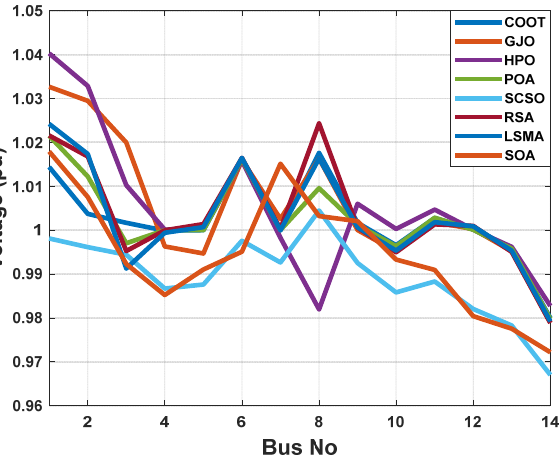
Figure 10. The voltage profile of the POA and other compared algorithms for case 3 in a standard IEEE 14-bus test system.